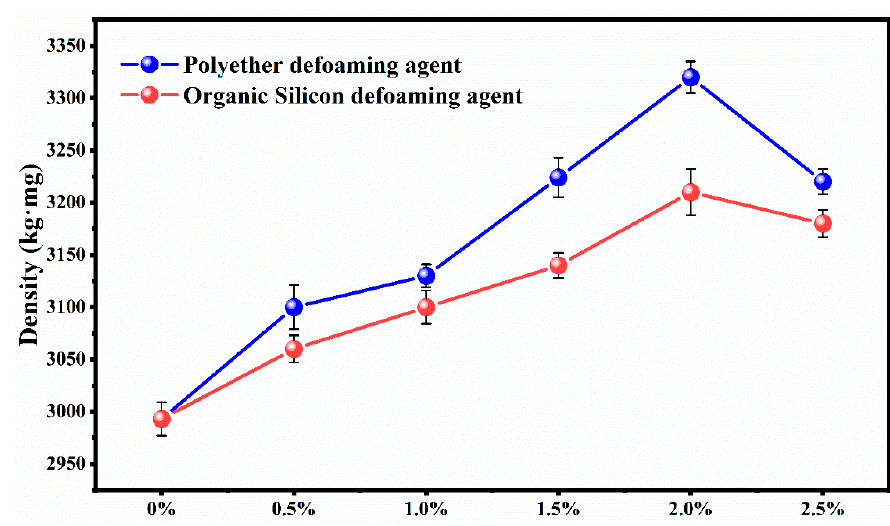
Figure 8. Mobility.